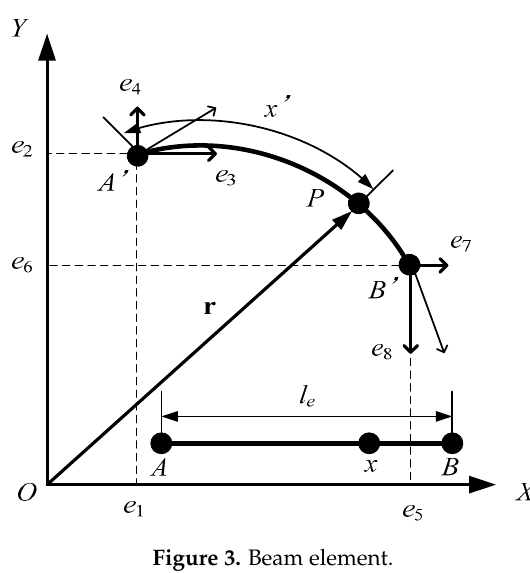
Figure 3. Beam element.